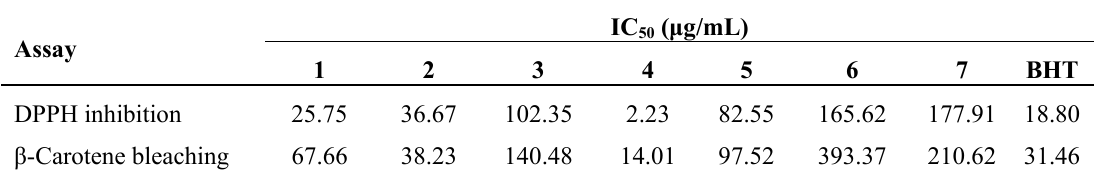
Table 3. Antioxidant activity of the flavonoids from H. caspica .